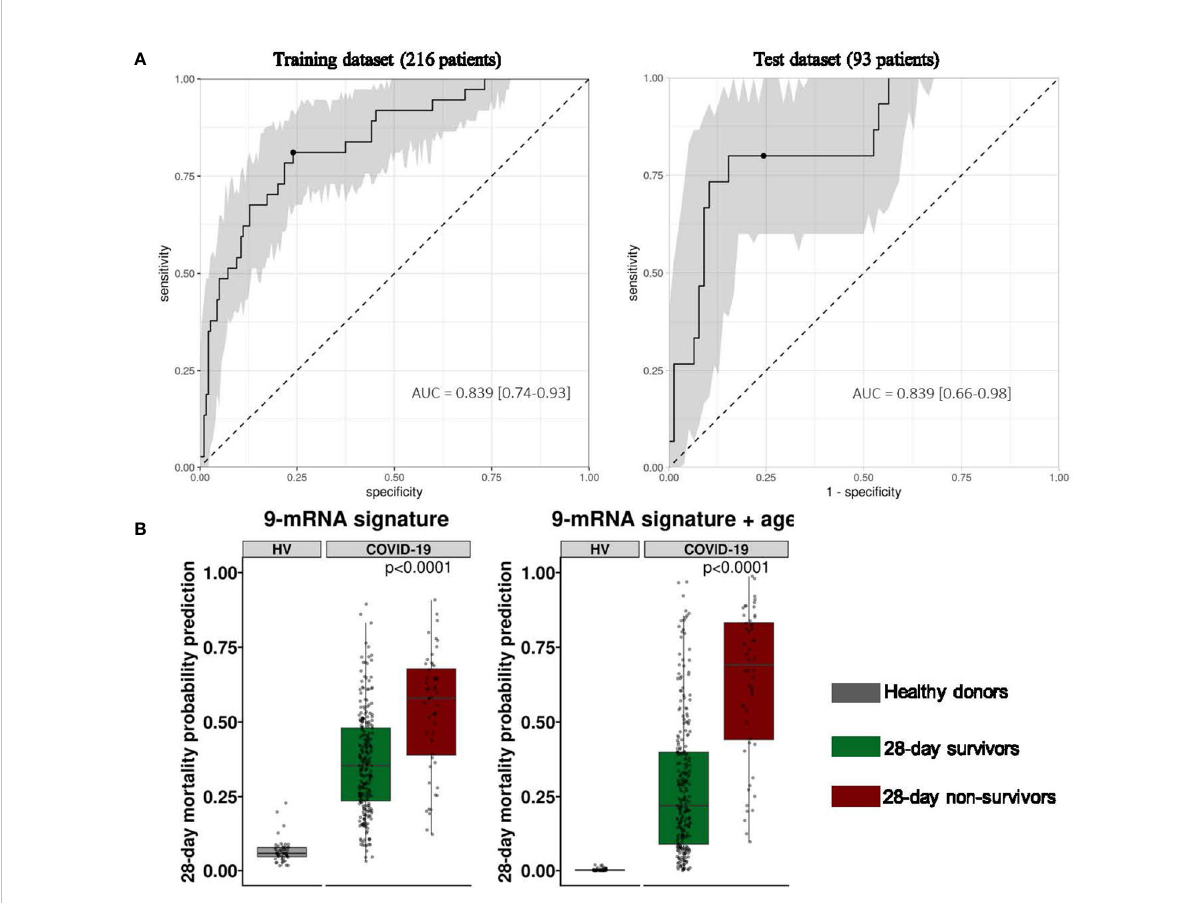
FIGURE 4 Performanceofthe9-mRNAsignaturecombinedwithagetopredict28-daysurvivalstatusincriticallyillCOVID-19patientsatICUadmission. (A) AreaUnder theReceiverOperatingCharacteristicscurve(AUC)calculatedonthetrainingdatasetof216patientsandtheindependenttestsetof93criticallyillCOVID-19 patientsusingthe9-mRNApanelalongwiththeageattheiradmissioninICU.The95%con fi denceinterval(grey)iscalculatedusingbootstrapwith1000 repetitions. (B) Probabilityof28-daymortalityfromlinearSVMmodeltrainedon9-genepanel(left)and9-genepanelcombinedwithage(right)ontheentire